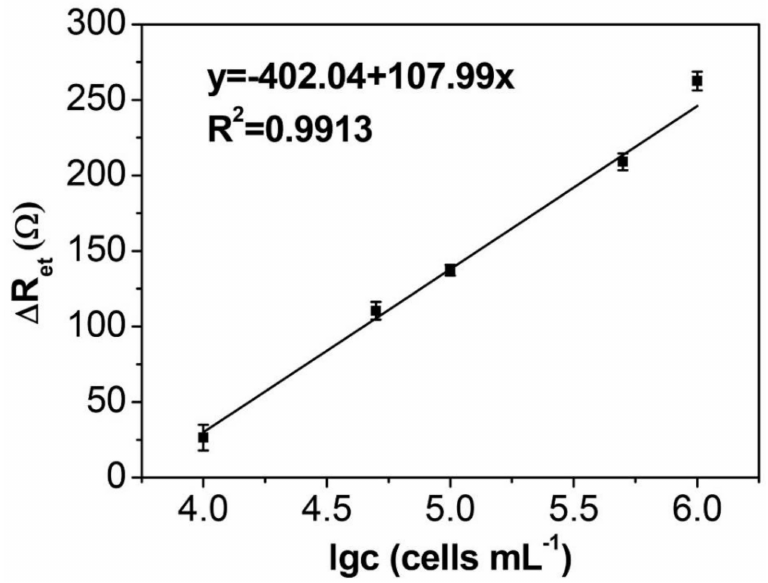
Figure 5. Plot of the ∆ R et ( ∆ R et = R cells − R BSA ) against the target cancer cell at di ff erent concentrations. The data are obtained from at least three parallel